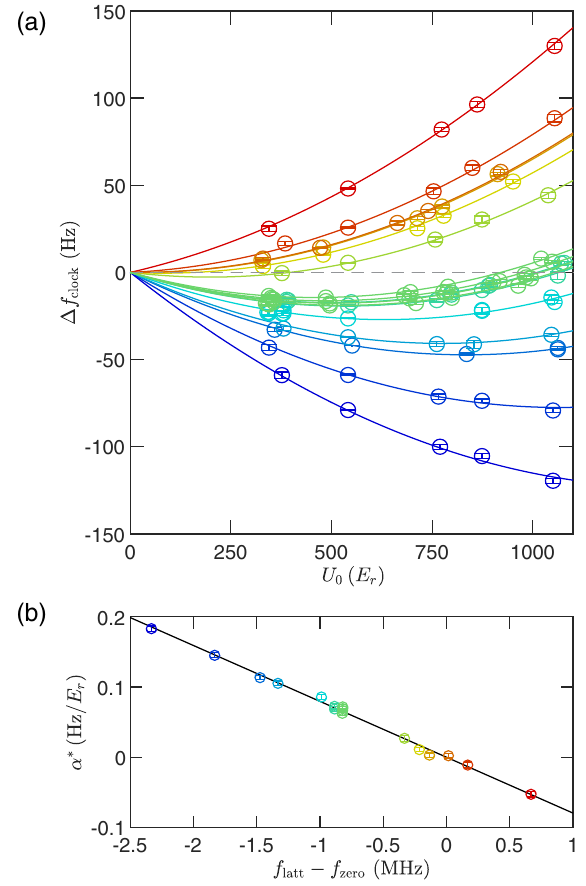
FIG. 2. Clock shifts due to the lattice light. (a) Nonlinear shifts of the molecular clock frequency versus trap depth. For a given lattice frequency (color coded), we make interleaved measure- ments of clock shifts (open circles) with respect to a reference trap depth (approximately 500 E ) and fit the data to parabolas r (solid lines) with a global quadratic parameter, − β (cid:2) . (b) Linear light-shift coefficient α (cid:2) versus lattice frequency [color code matches (a)] and the linear fit (black solid line). α (cid:2) is predomi- nantly due to the E 1 differential polarizability and is nulled at f . By tuning α (cid:2) , we can find conditions where the sensitivity zero of Δ f to fluctuations in U 0 is minimal at our operational trap clock depth of 487(4) E (dark green points). Error bars represent 1 r